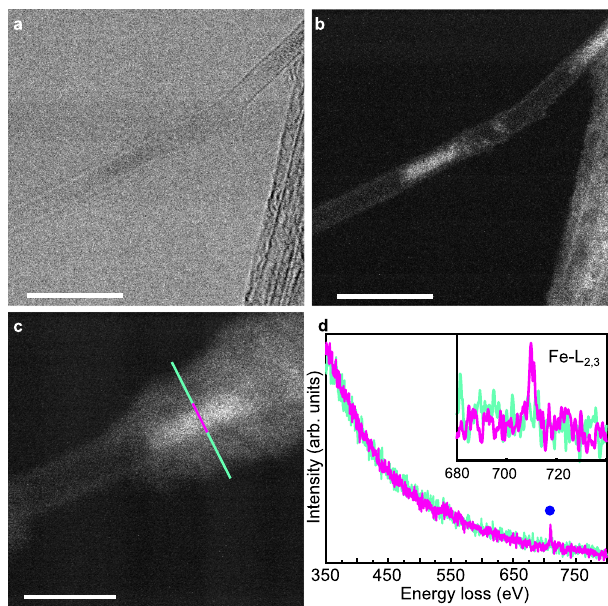
Fig. 2 Presence of the Fe-SCO within the SWCNT. a Bright- fi eld scanning transmission electron microscope (BF-STEM) image of one SCO1@SWCNT sample (acceleration voltage 80kV). Scale bar: 10 nm. b High-angle annular dark- fi eld (HAADF)-STEM image of the SCO1@SWCNT depicted in a . Scale bar: 10 nm. c Ampli fi ed section of b . Scale bar: 5 nm. d Average electron energy loss spectra (EELS) measured across the turquoise and magenta lines in c